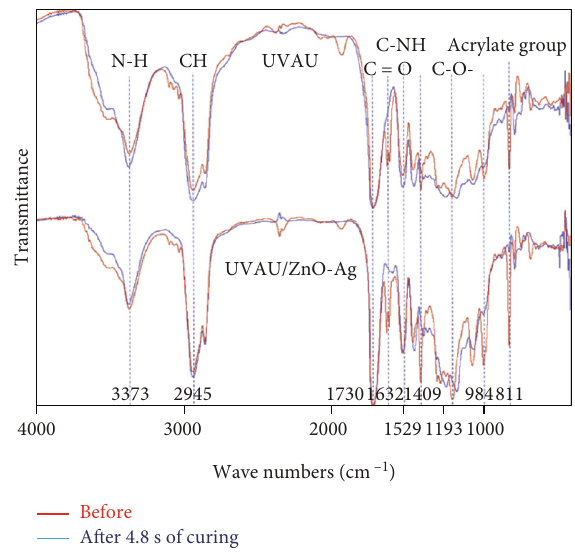
Figure 4: IR spectra of the UV-curable E.284/HDDA/I.184 systems without (UVAU) and with 2wt% ZnO-Ag nanohybrids (UVAU/ZnO-Ag) before and after 4.8s UV light